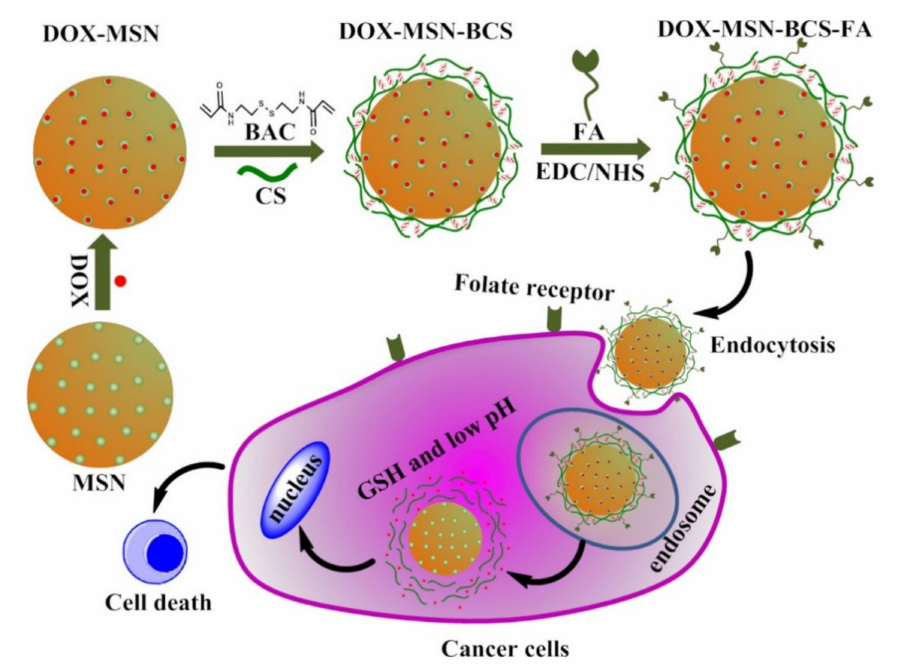
Figure 17. The synthesis procedure of DOX-MSN-BCS-FA and the extracellular and intracellular trafficking for DOX-MSN-BCS-FA to cancer cells [121]. Reproduced with permission from Elsevier